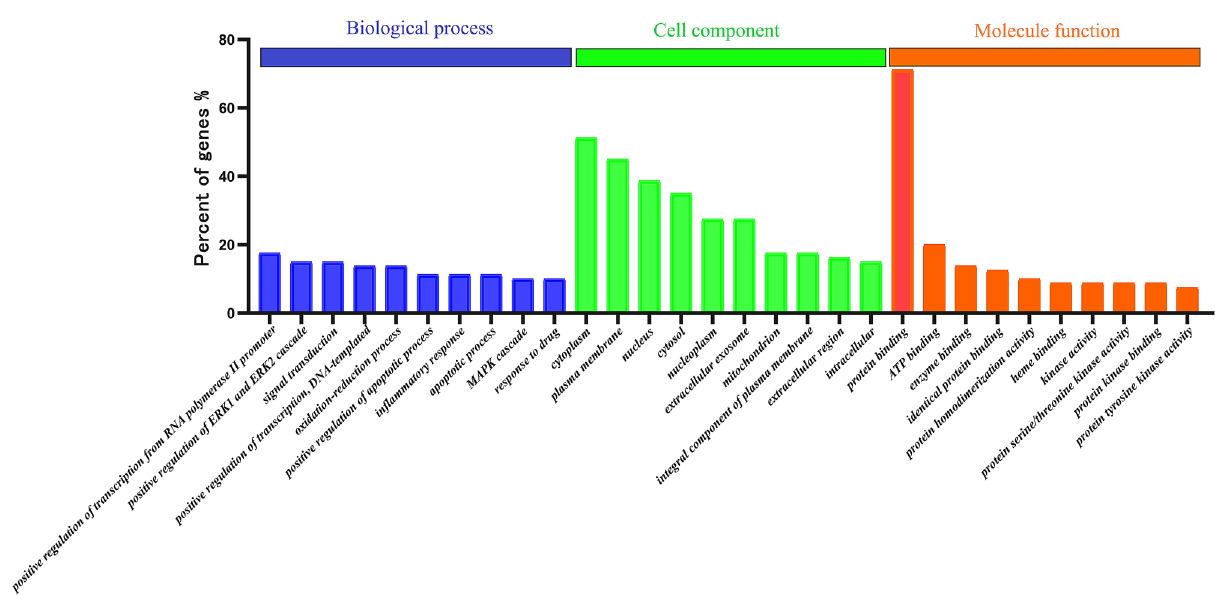
Figure 3. The enrichment ratios of target proteins in biological process, cell composition and molecular function in biological function obtained by GO enrichment